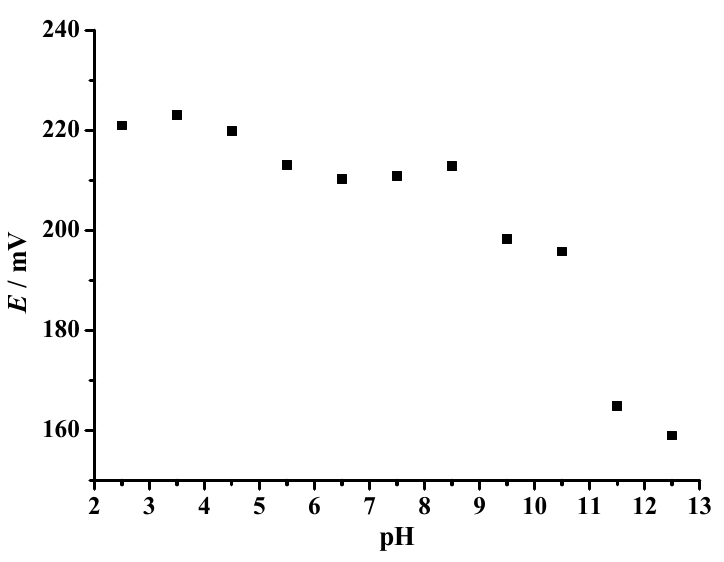
Figure 8. Effect of pH on the response of the prepared planar ammonium selective electrode.